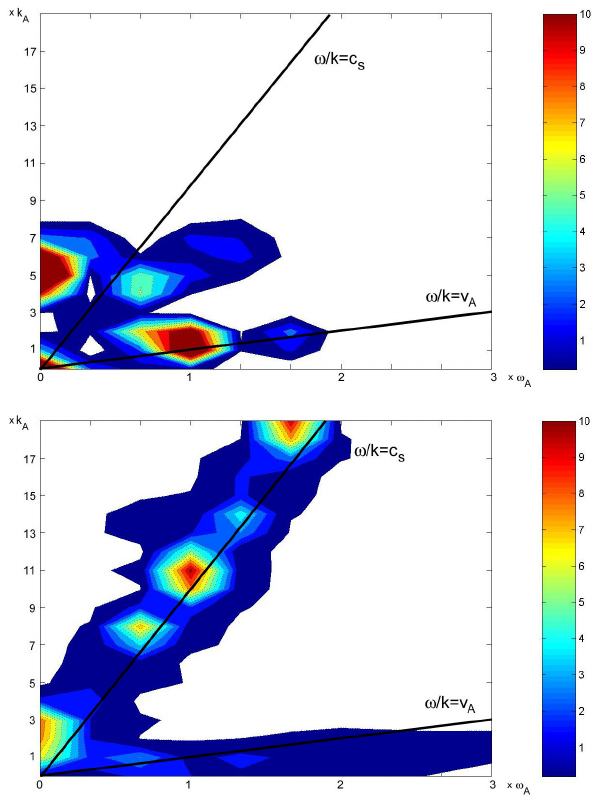
Fig. 6. Two-dimensional spectra of the magnetic field perturba- tion B y ( ω ,k) and the parallel electric field E x ( ω ,k), calculated for the time interval 10 T A -15 T A . Horizontal axes give the frequency in ω A units, and vertical axes give the wave number in k A units. The values of B y ( ω ,k) and E x ( ω ,k) are shown in arbitrary units by color scale. Solid lines denote the dispersion curves for Alfv´eng and sound